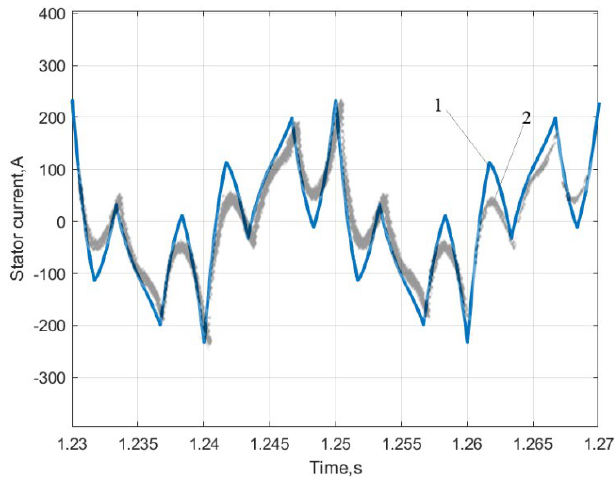
Figure 14. Stator current of 3PIM in steady-state mode for the 6-step VSI supplying: 1—simulation, 2—experimental data adapted from [1].